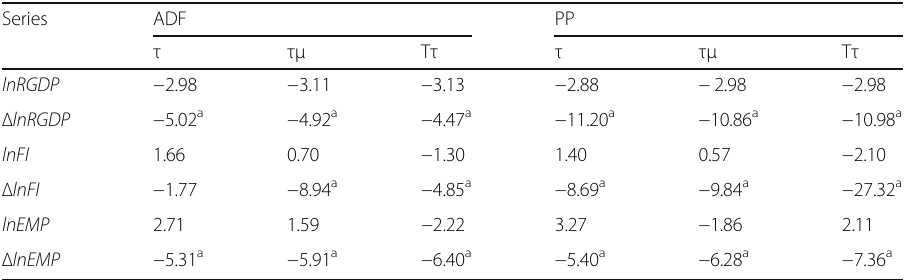
Table 4 Unit root